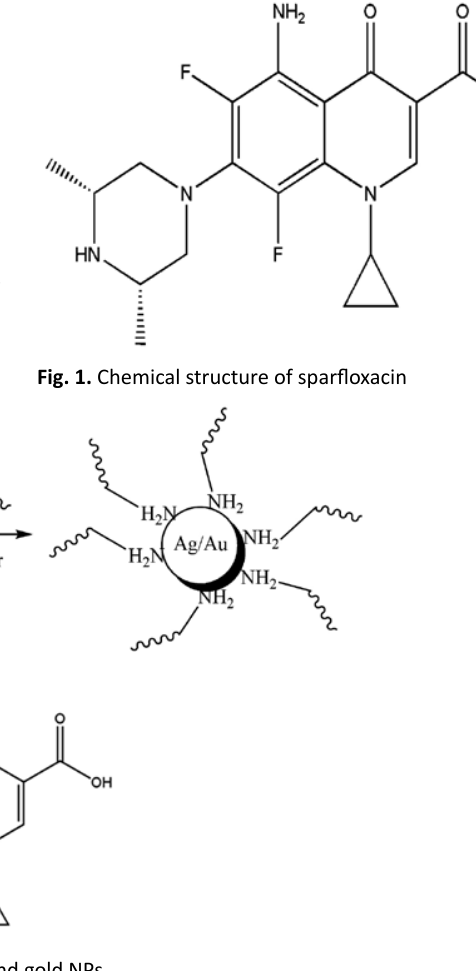
Scheme 1. Capping action of sparfloxacin with silver and gold